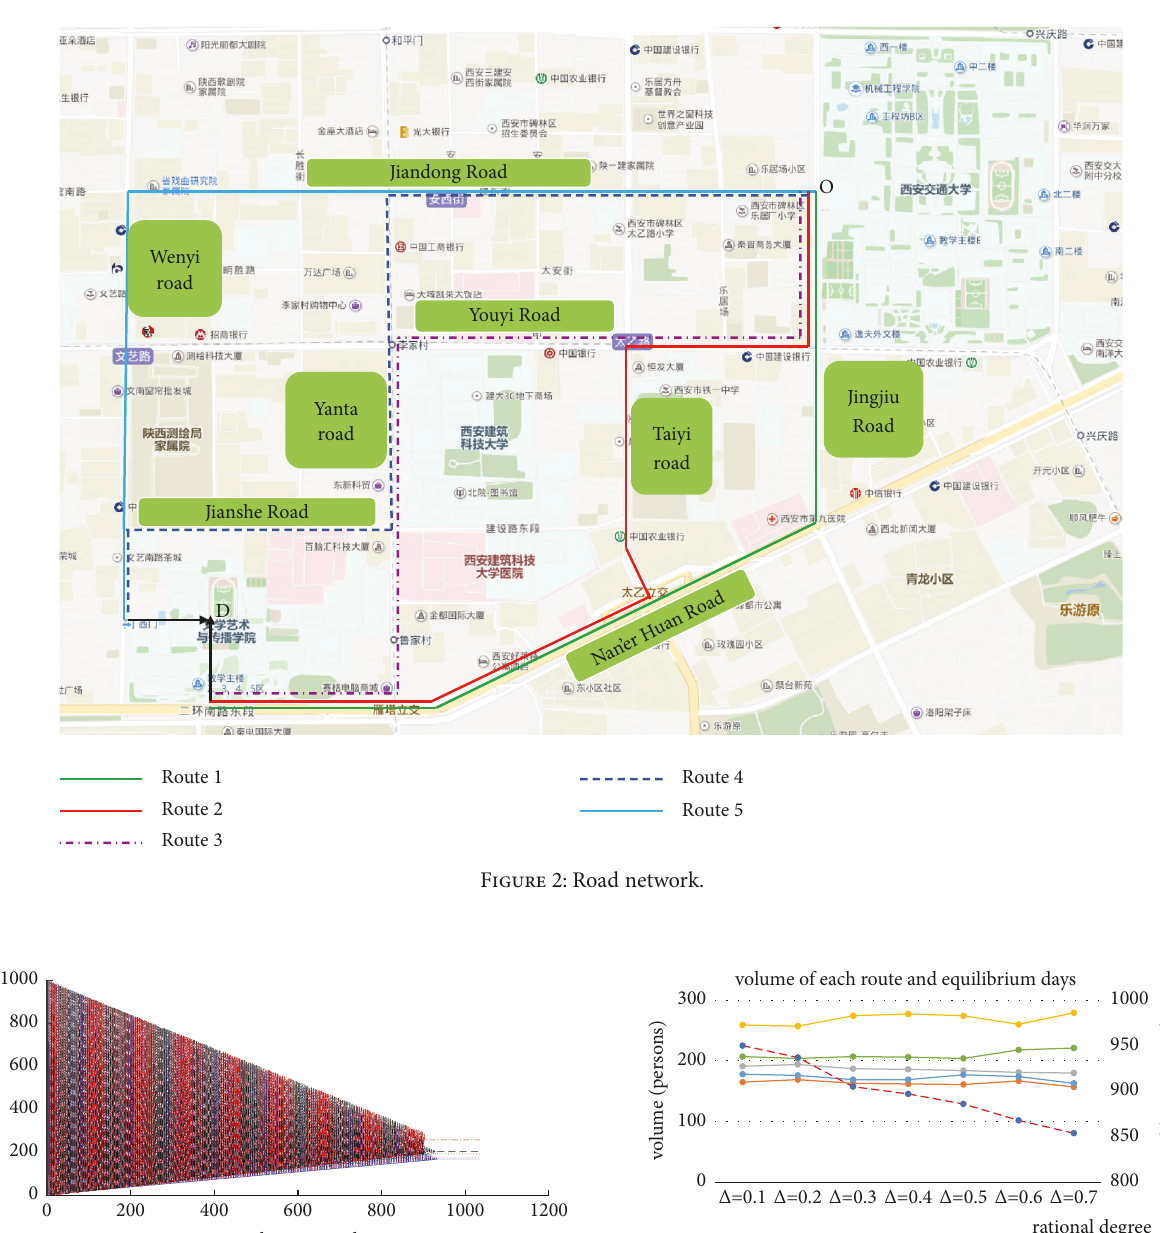
Figure 4: Volume evolution of five routes for 𝑞 = 1000 , 𝛼 = 0.3 , 𝜃 = 0.2 𝑖